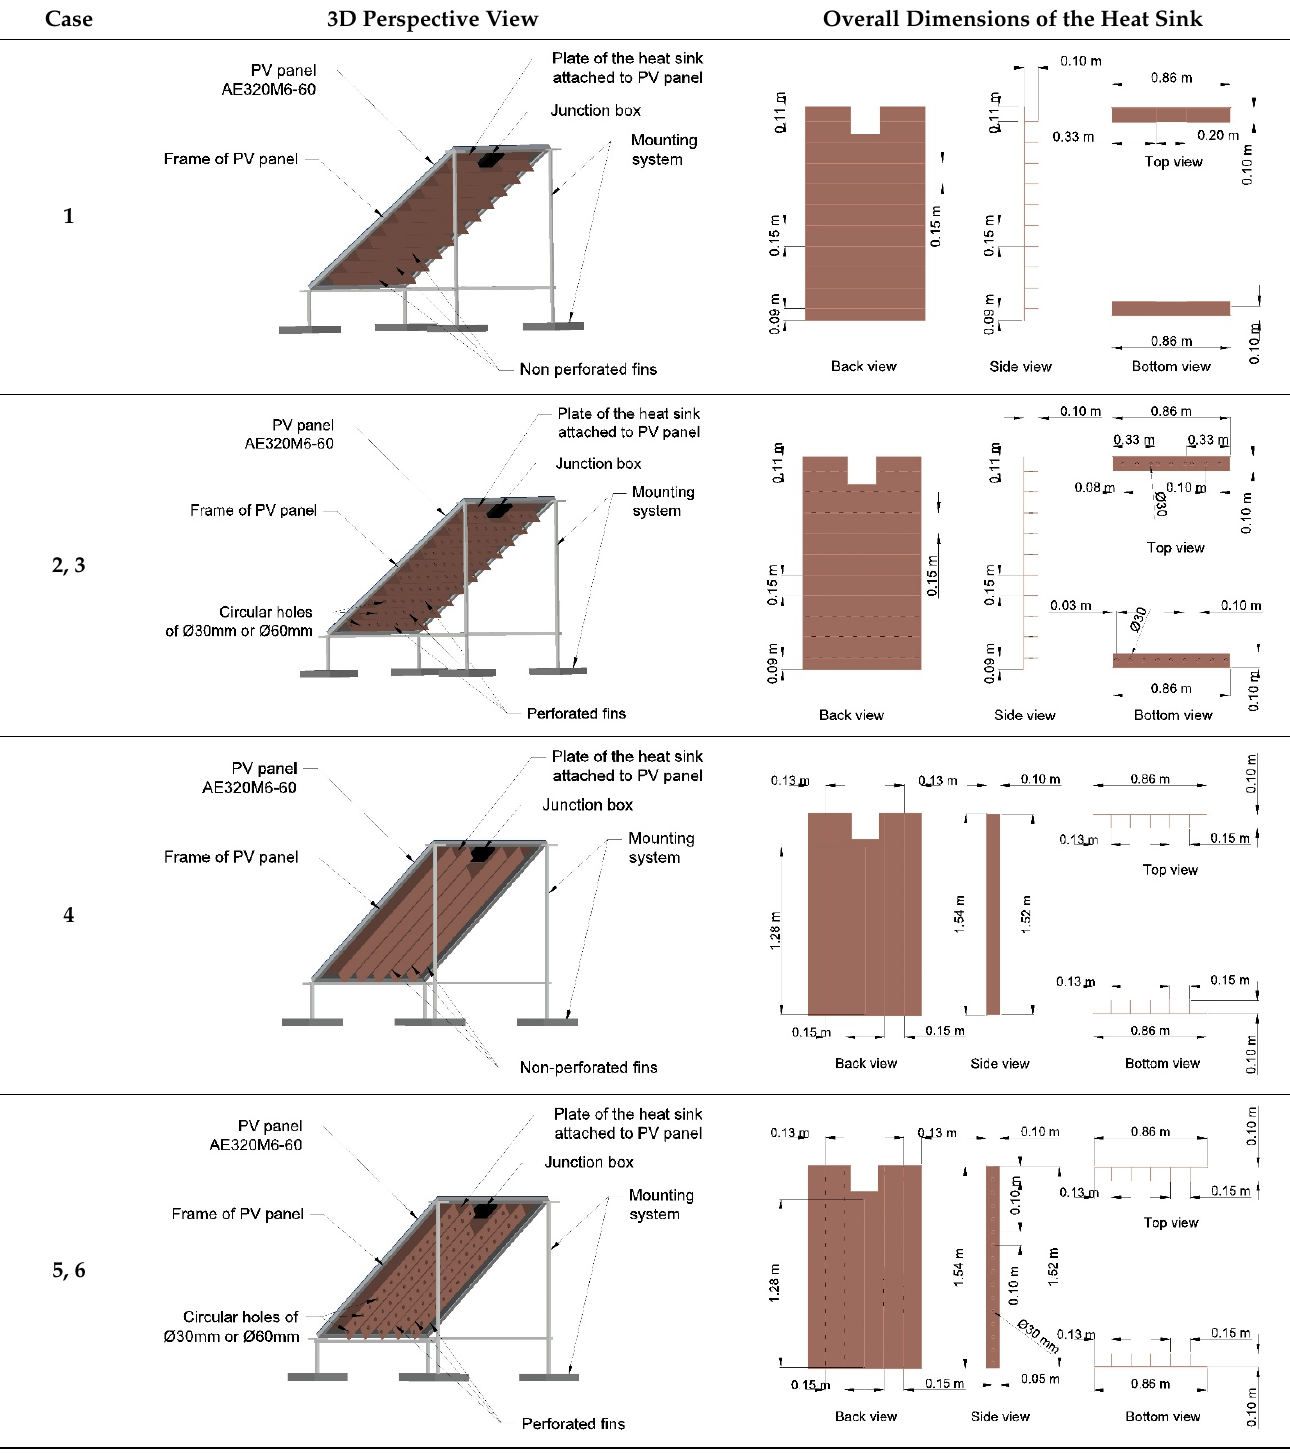
Table 4. Components of the model and overall dimensions of the heat sinks.